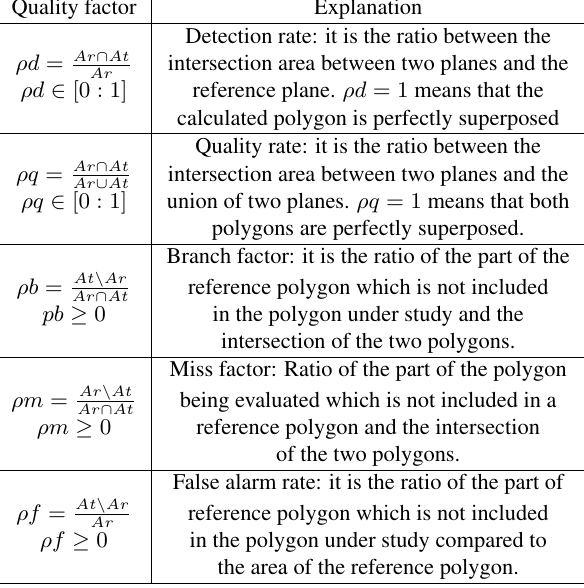
Table 1: Quality indices based on surface areas ratios.